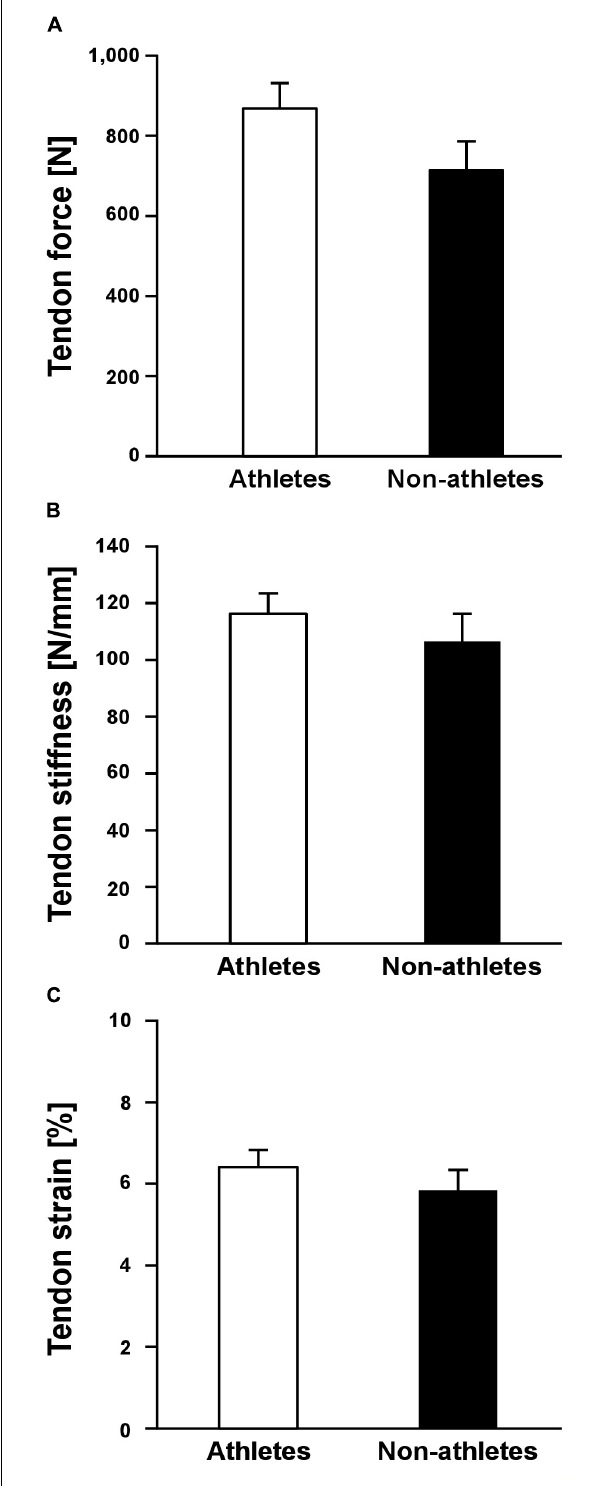
FIGURE 2 | Mean values and standard error (error bars) of Achilles tendon force (A) , tendon stiffness (B) and tendon strain (C) during maximum isometric contractions of preadolescent athletes and non-athletes. No significant differences ( p > 0.05) were found between the two